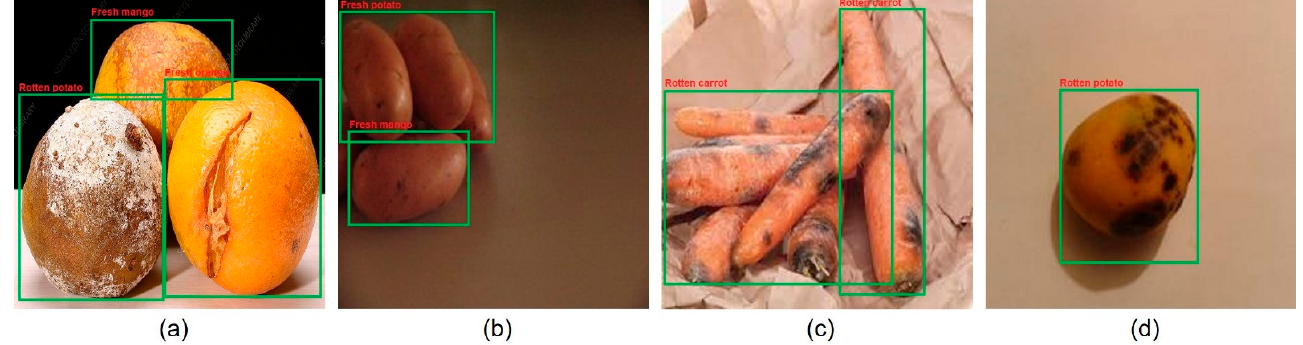
Figure 11. Experimental results showing limitations of the proposed system: (a) Rotten oranges are misclassified as rotten potato, fresh mango, and fresh orange, ( b ) Fresh potatoes are misclassified as misclassified as rotten potato, fresh mango, and fresh orange, (b) Fresh potatoes are misclassified as fresh mango, (c) Rotten carrots, (d) Rotten mango is misclassified as rotten potato. fresh mango, ( c ) Rotten carrots, ( d ) Rotten mango is misclassified as rotten potato.